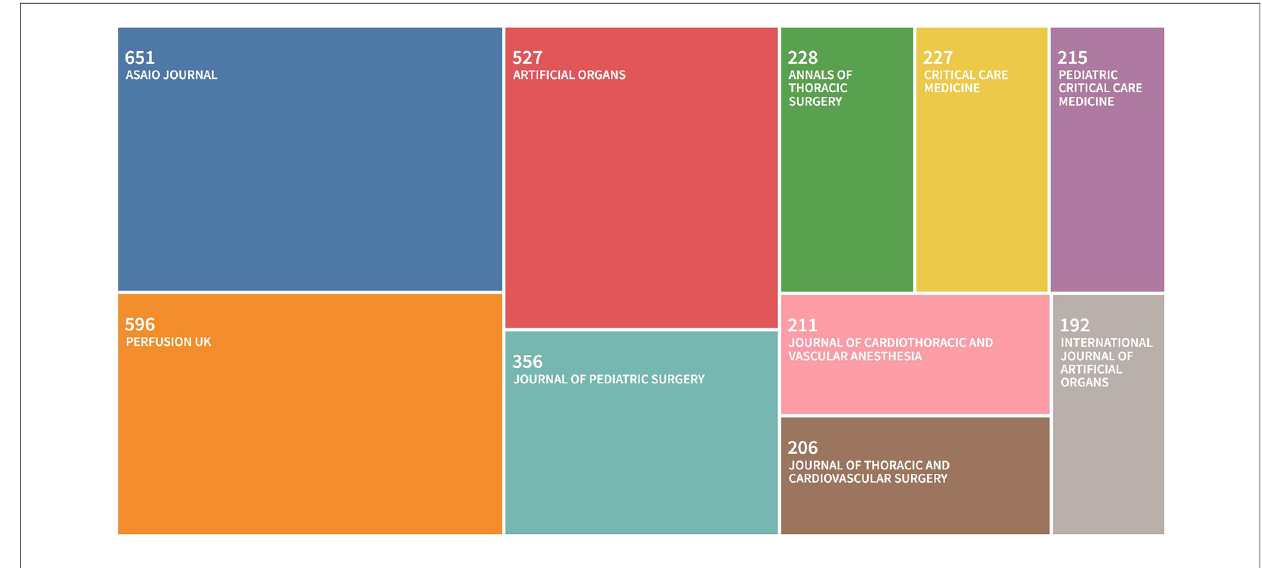
FIGURE 3 Top 10 source journals for ECMO research